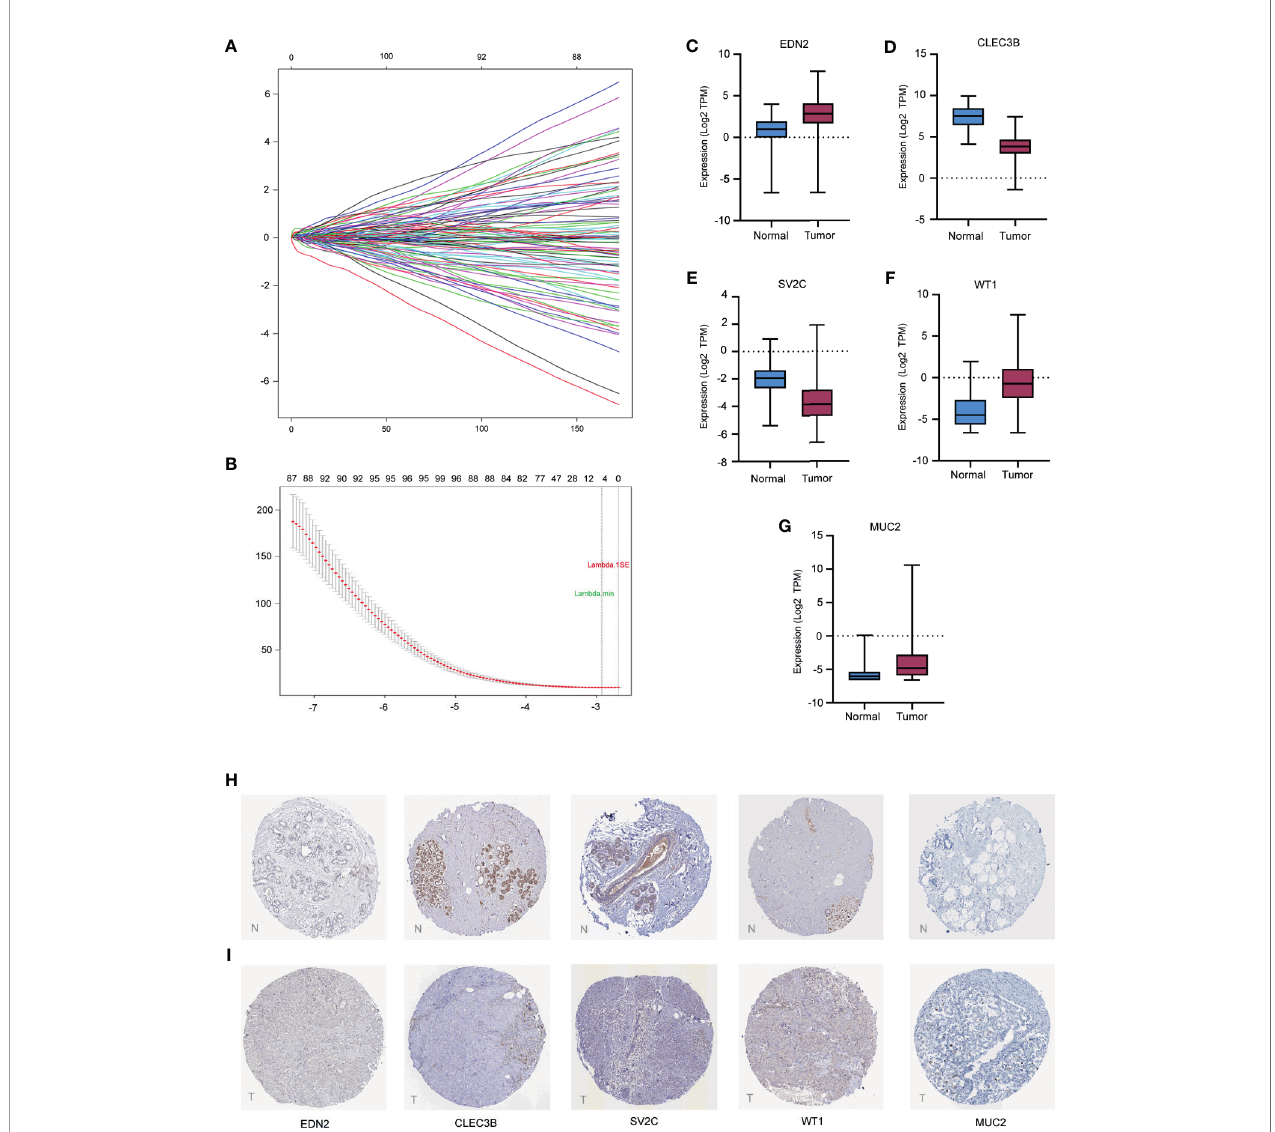
FIGURE 5 | Construction of the fi ve-gene prognostic model and validation of expression of the fi ve genes in breast cancer. (A) the coef fi cients of variables identi fi ed based on the LASSO Cox regression model. (B) 10-fold Cross validation of LASSO regression. Left and right vertical dotted lines represented the “ lambda.min ” and “ lambda.1se ” criteria, respectively. The red dots indicated partial likelihood deviance values, and the gray lines indicated the corresponding standard error. (C – G) The mRNA expression levels of selected genes in the TCGA training cohort. (H, I) The representative protein expression of the fi ve genes in breast cancer tumor tissue and normal tissue. Data were obtained from the human protein atlas.